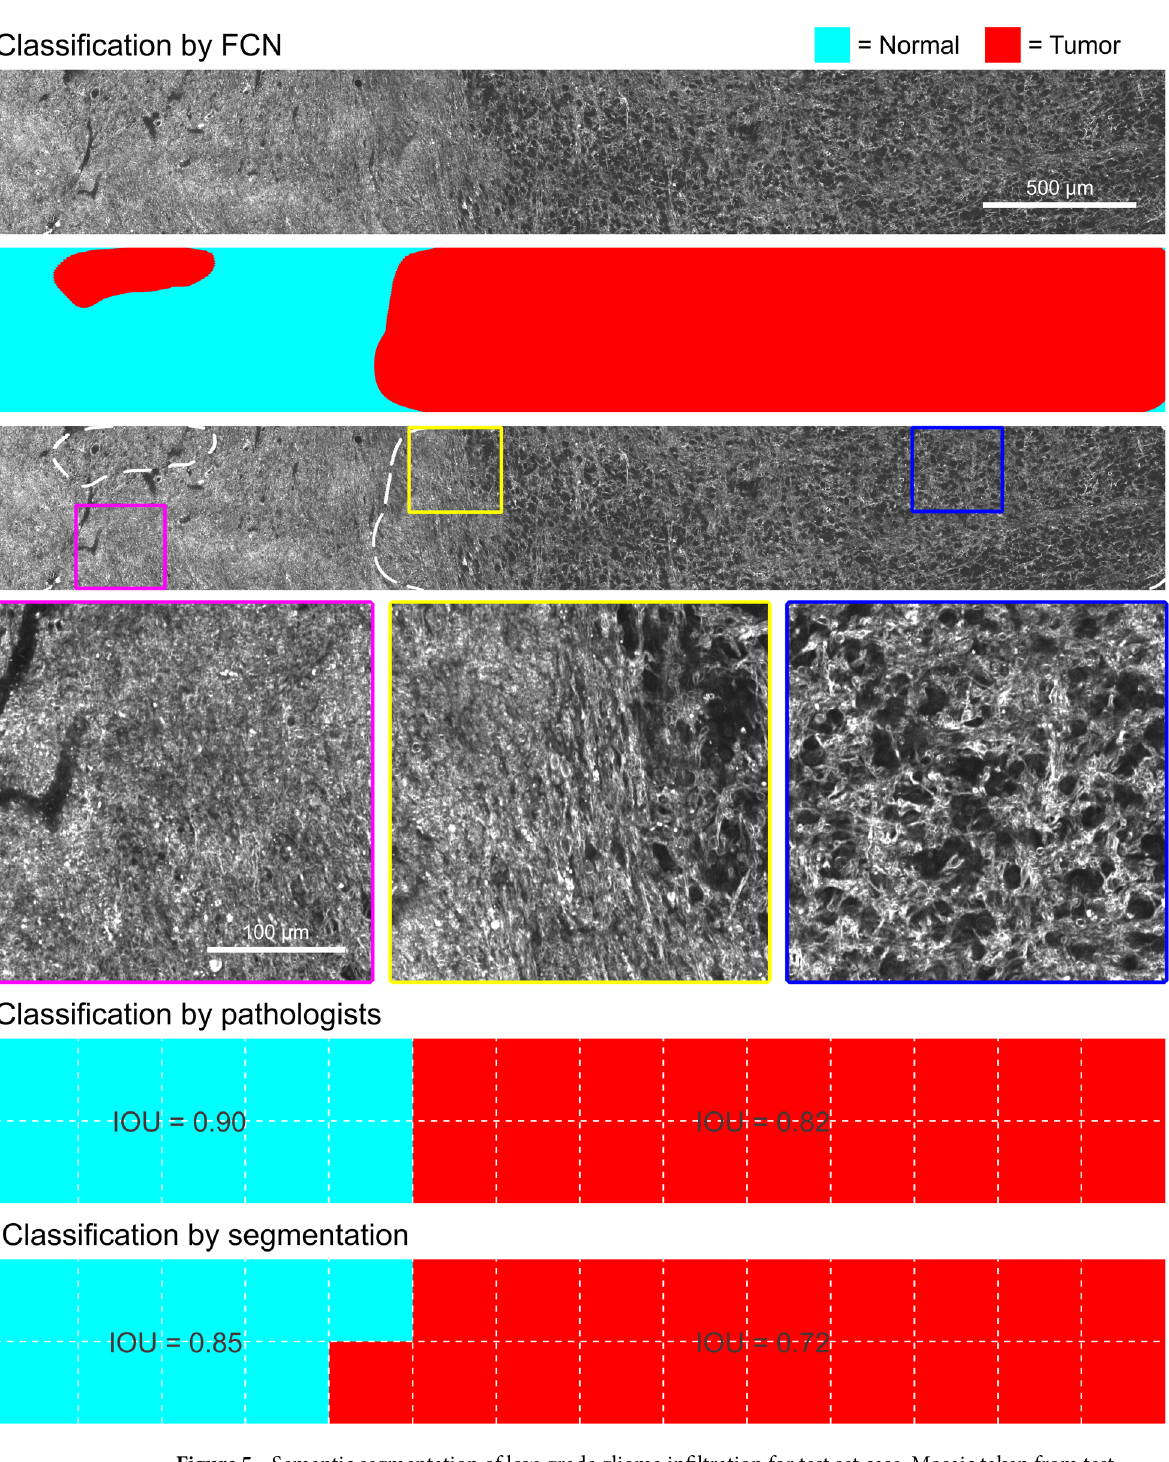
segmentation based on active contour, performing quantitative analysis on the segmented neural cell bodies, nuclei and myelinated fibers. Evaluated on the same hold-out testing set (inherited from Zhang et al.), clas- sification by segmentation reports an accuracy of 93%, compared to 79% from classification by deep learning. The scores reported here are measured against the agreement of 3 pathologists on the testing set. On average,